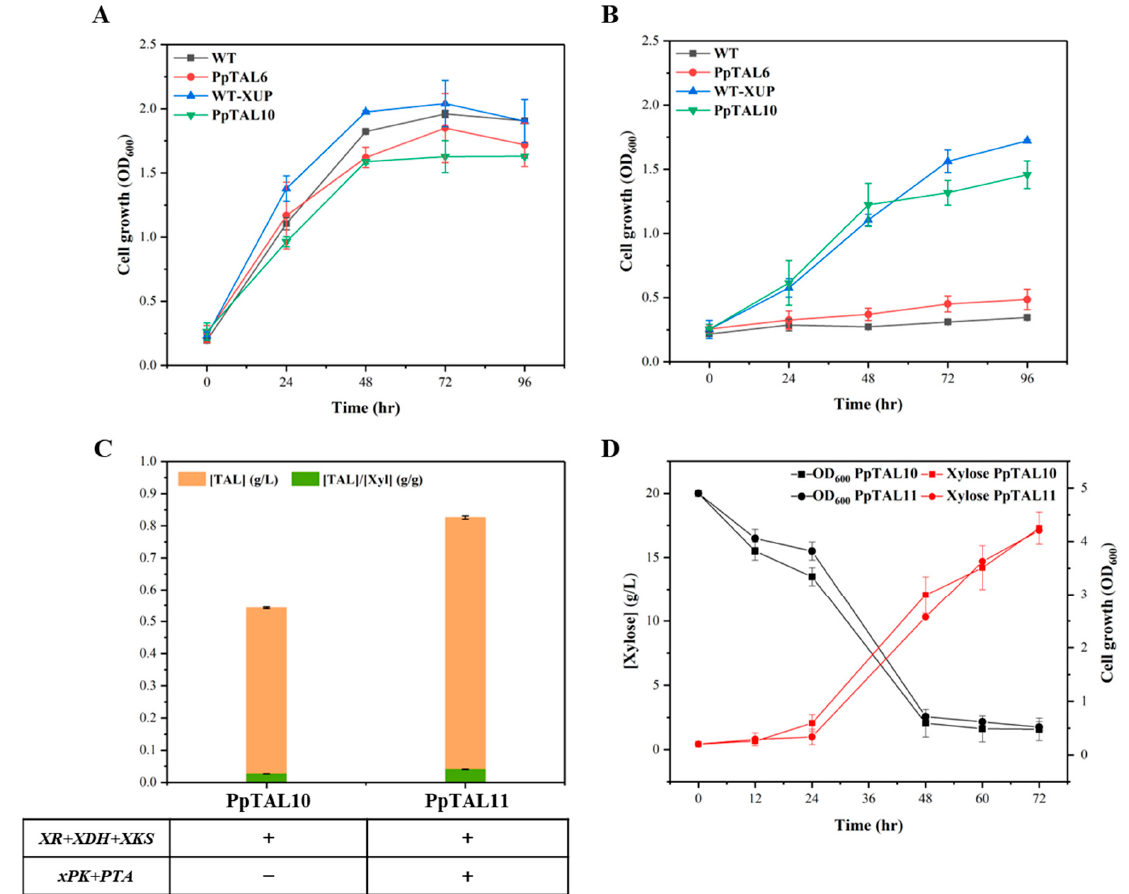
Figure 4. TAL production from xylose in P. pastoris . Functional verification of the xylose utilization pathway was performed by measuring the cell growth of WT, PpTAL6, and the corresponding PK pathway integrated strains (WT − XUP and PpTAL10) in SCX medium ( A ) and SCD medium ( B ). ( C ) Comparison of TAL titer in the xylose utilization pathway integrated strains with (PpTAL11) or without (PpTAL10) the PK pathway in SCX fermentation medium. ( D ) The xylose consumption rate and cell growth curves of PpTAL10 and PpTAL11 in SCX medium. The data represent three biological replicates, and the error bars represent standard